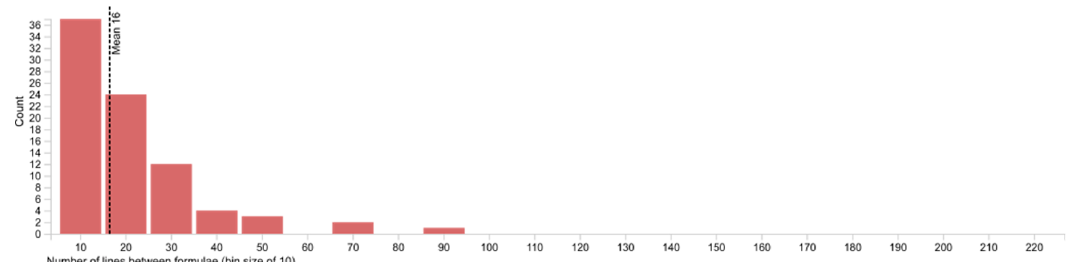
Figure 3. Histogram of formula spacing in Andreas .